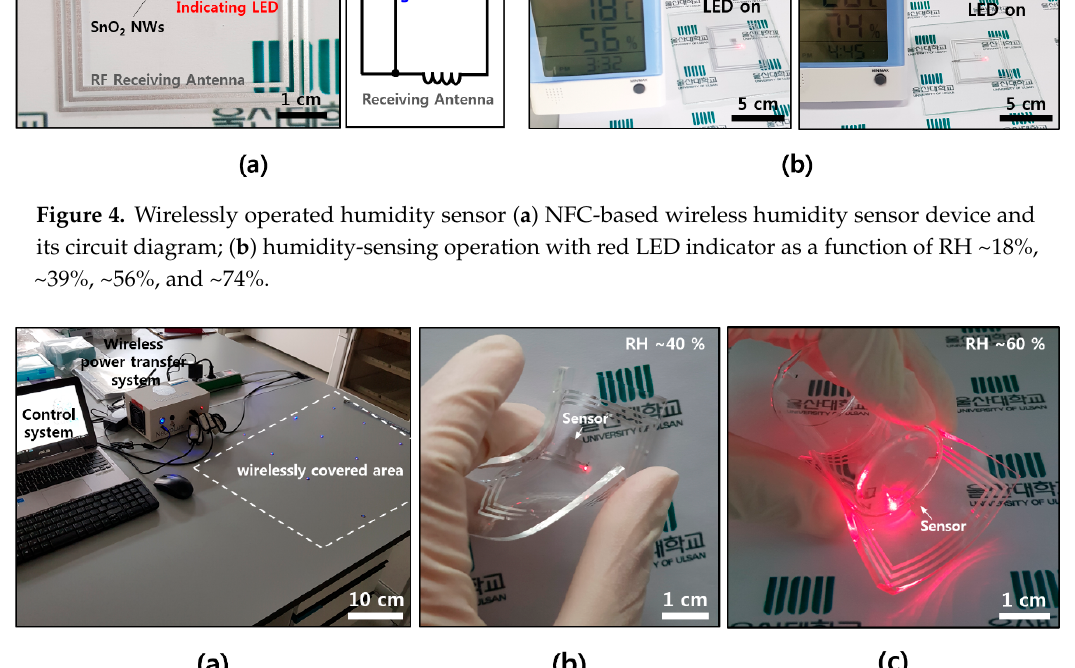
Figure 5. Photographs of wireless system and devices. ( a ) Wireless power transfer and control system with covering area; ( b ) wireless sensing operation at a RH of ~40% in a bent state; and ( c ) wireless sensing operation at a RH of ~60% after wrapping on the small beaker (diameter of ~3 cm).